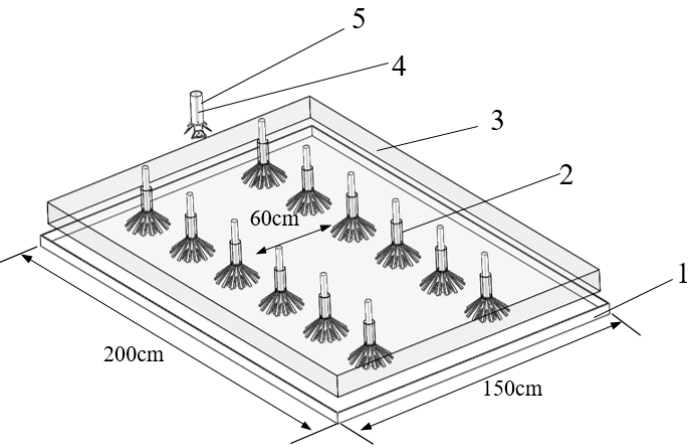
Figure 5. Simulation test model. 1. Ground, 2. corn root stubble, 3. soil particles factory, 4. fertilizer particles factory, 5. corn-overlapped strip fertilizer spreader.